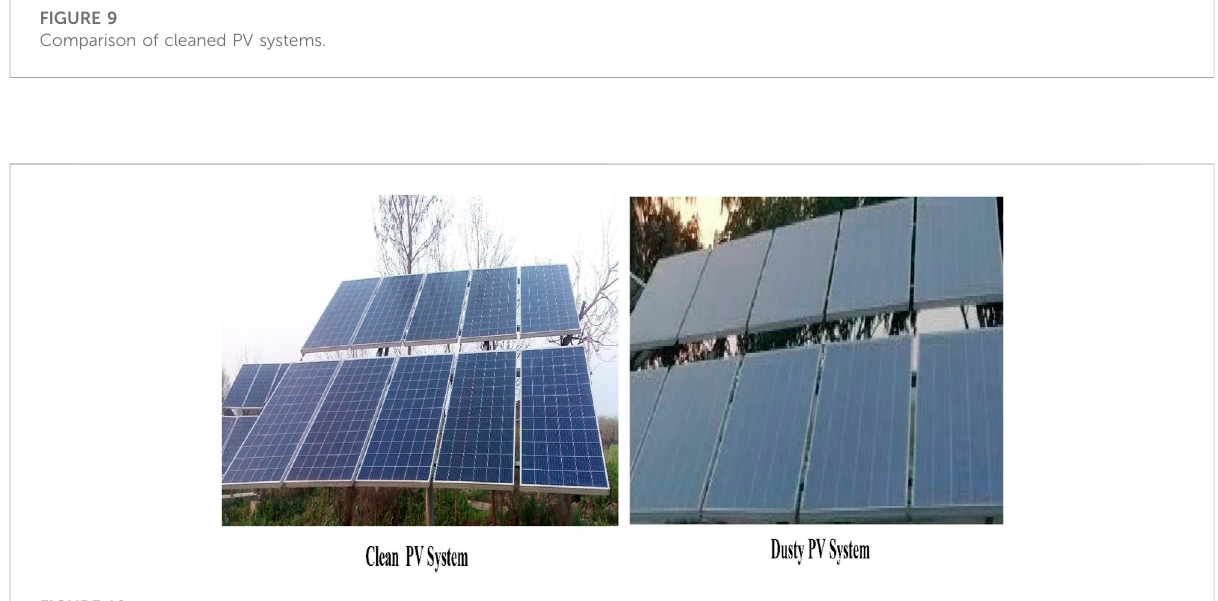
FIGURE 10 Installed PV